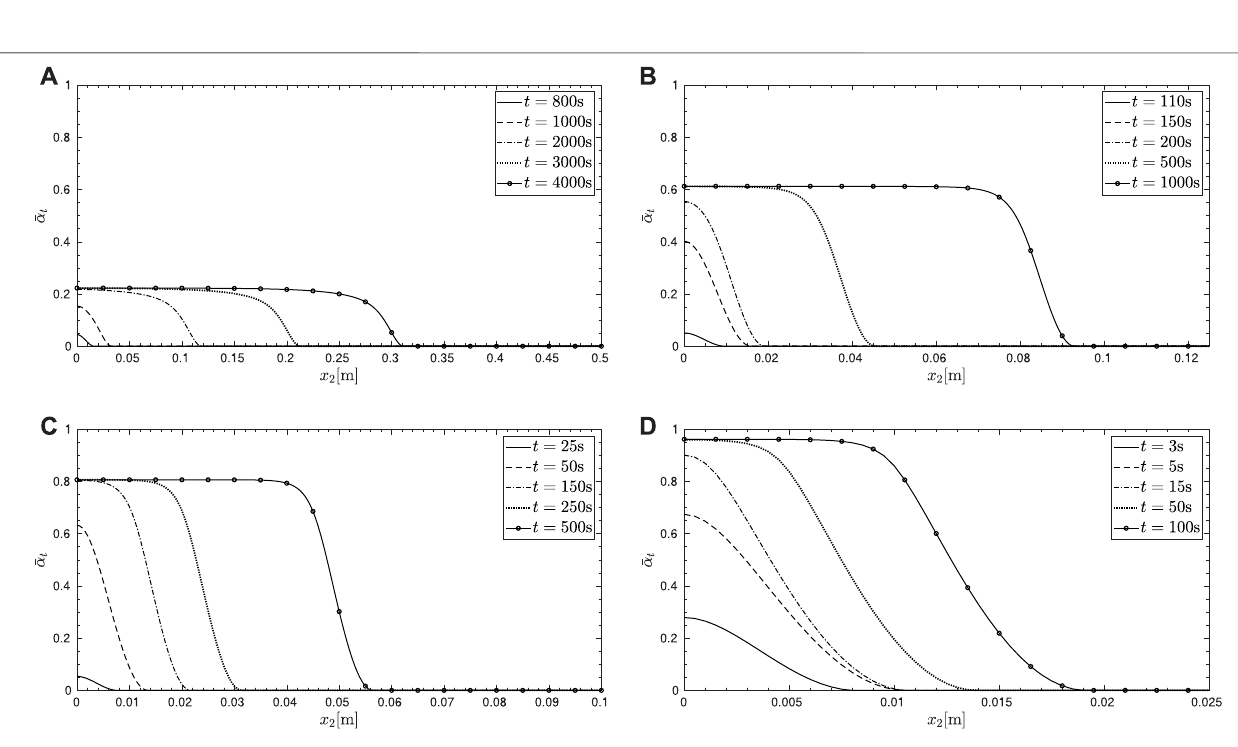
Frontiers in Mechanical Engineering |